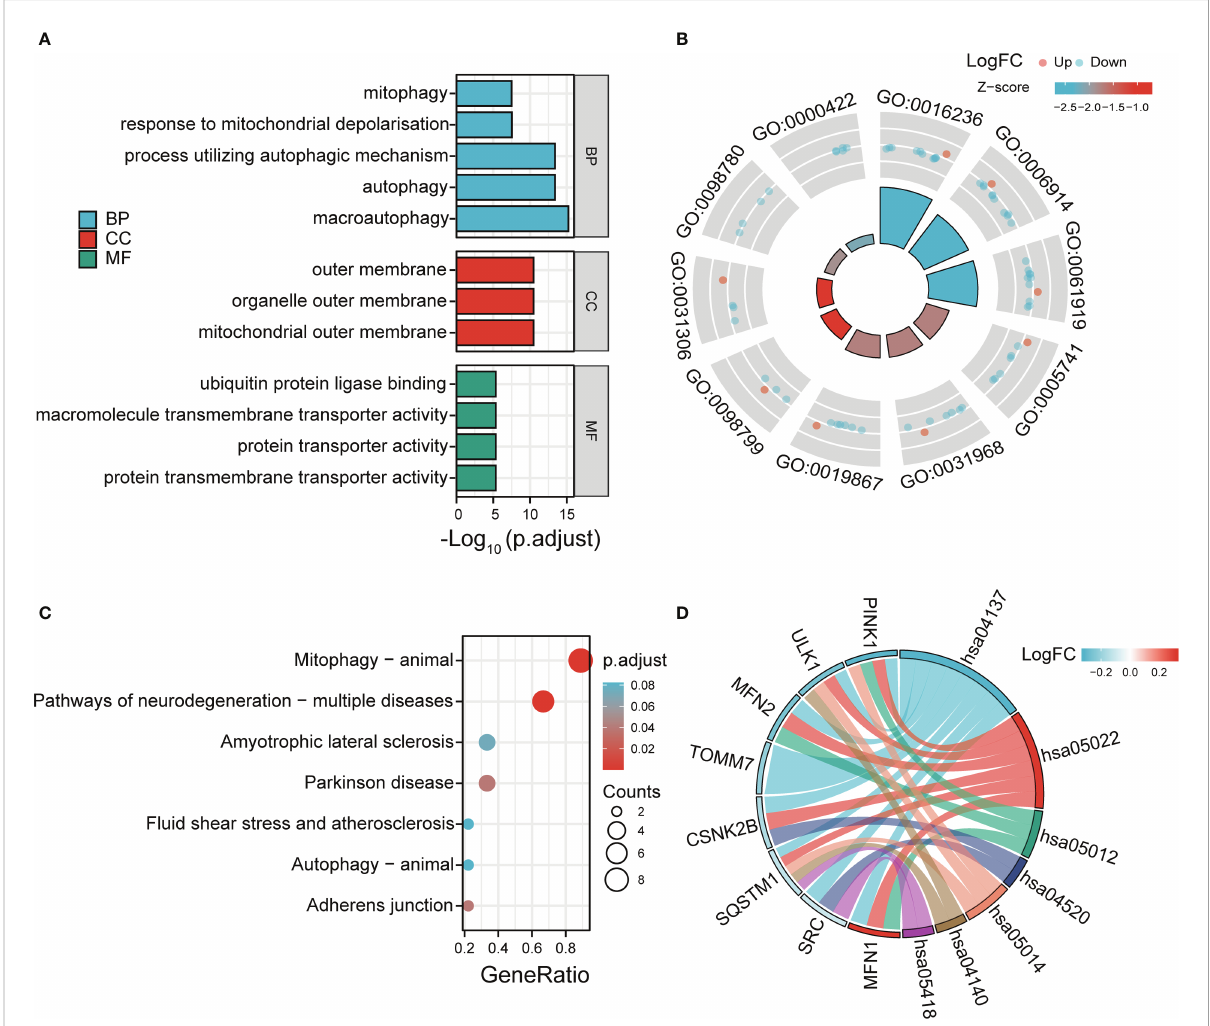
FIGURE 4 GO enrichment and KEGG analysis of 12 DE-MRGs. (A) Bubble plot of enriched GO terms. (B) Circos diagram of enriched GO terms. (C) Bubble plot of enriched KEGG terms. (D) Chord diagram of enriched KEGG terms. BP, biological process; CC, cellular component; MF, molecular